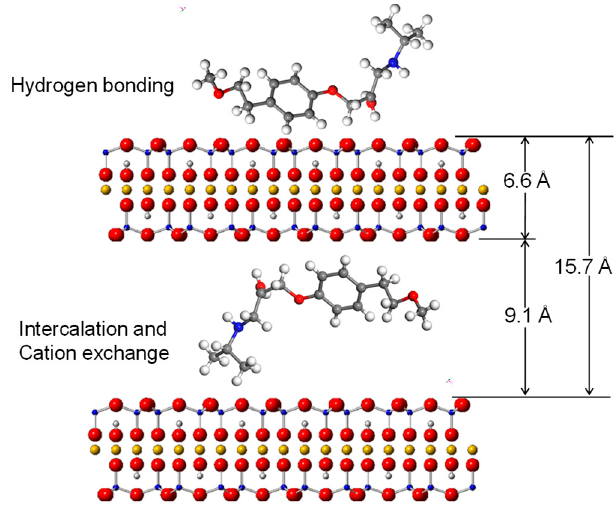
Figure 11. Illustration of intercalated AT inside the interlayers and in the outer surface of SAz-2 based on adsorption mechanism at low AT loading